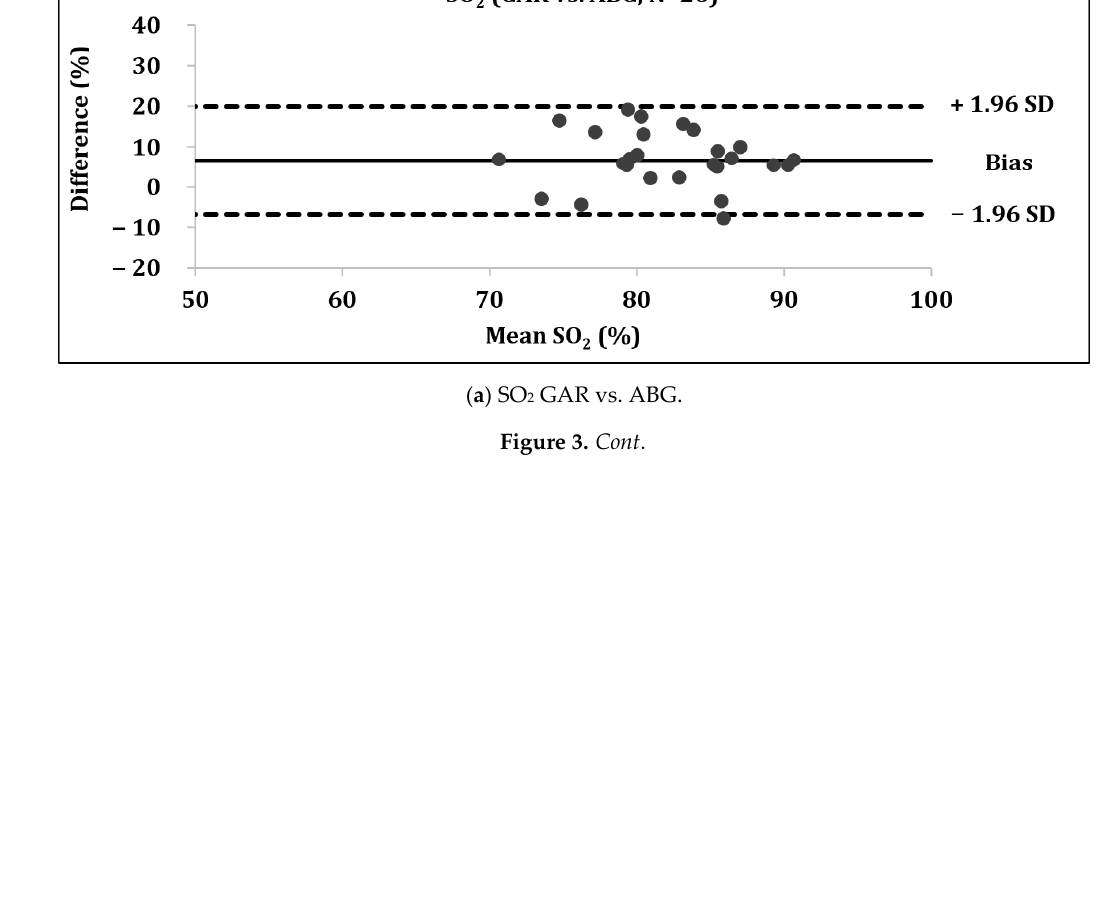
Figure 2. Scatterplot with regression line of ABG vs. GAR oxygen saturation in comparison to the line of identity. GAR = Garmin F ē nix ® 5X Plus; ABG = Radiometer ABL 90 Flex. Bland–Altman analysis indicated a low validity of GAR measurements (mean difference compared to ABG: 7.0%) with wide limits of agreement ( − 6.5; 20.5%), whereas the validity of COV was good (mean difference compared to ABG: 0.1%) despite wide limits of agreement ( − 10.7; 10.9%) (Figure 3).